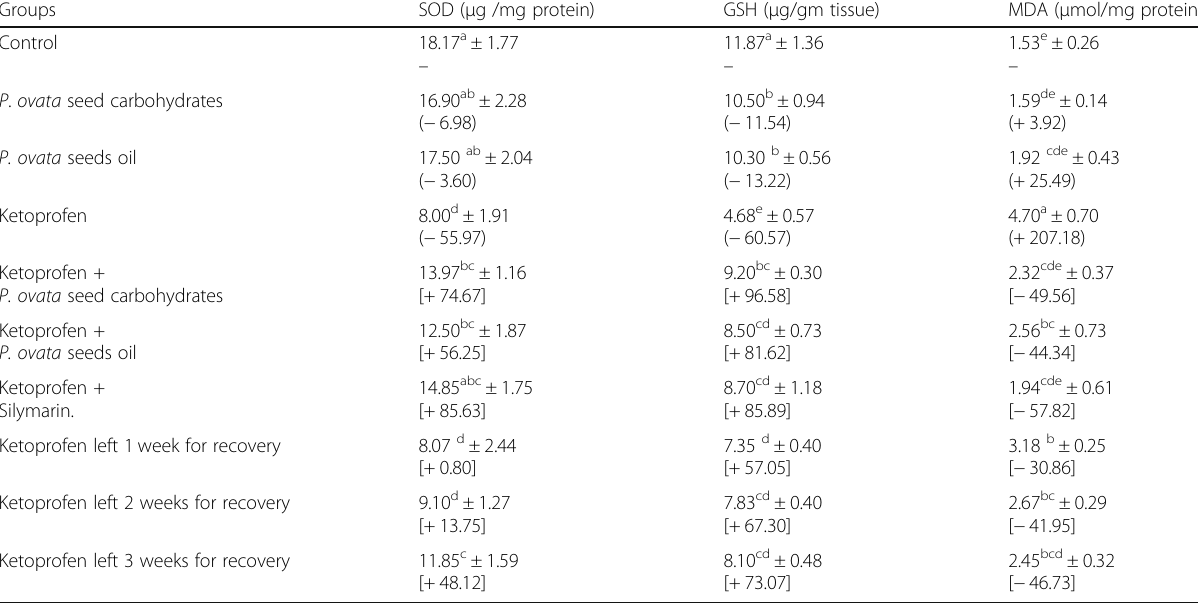
Table 5 Therapeutic effect of P . ovata seed carbohydrates and fixed oil on hepatic oxidative stress markers of ketoprofen toxicity in rats